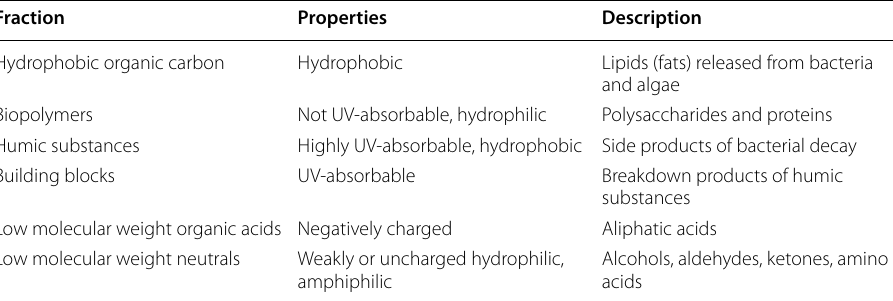
Table 2 Description of LC‑OCD fractions. Modified from Huber et al. (2011), Penru et al. (2013), and Zhu et al.